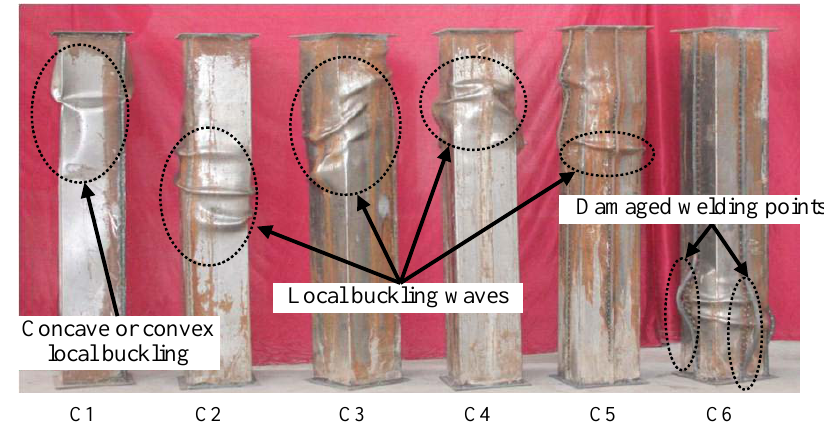
Figure 5. Failure modes of specimens.